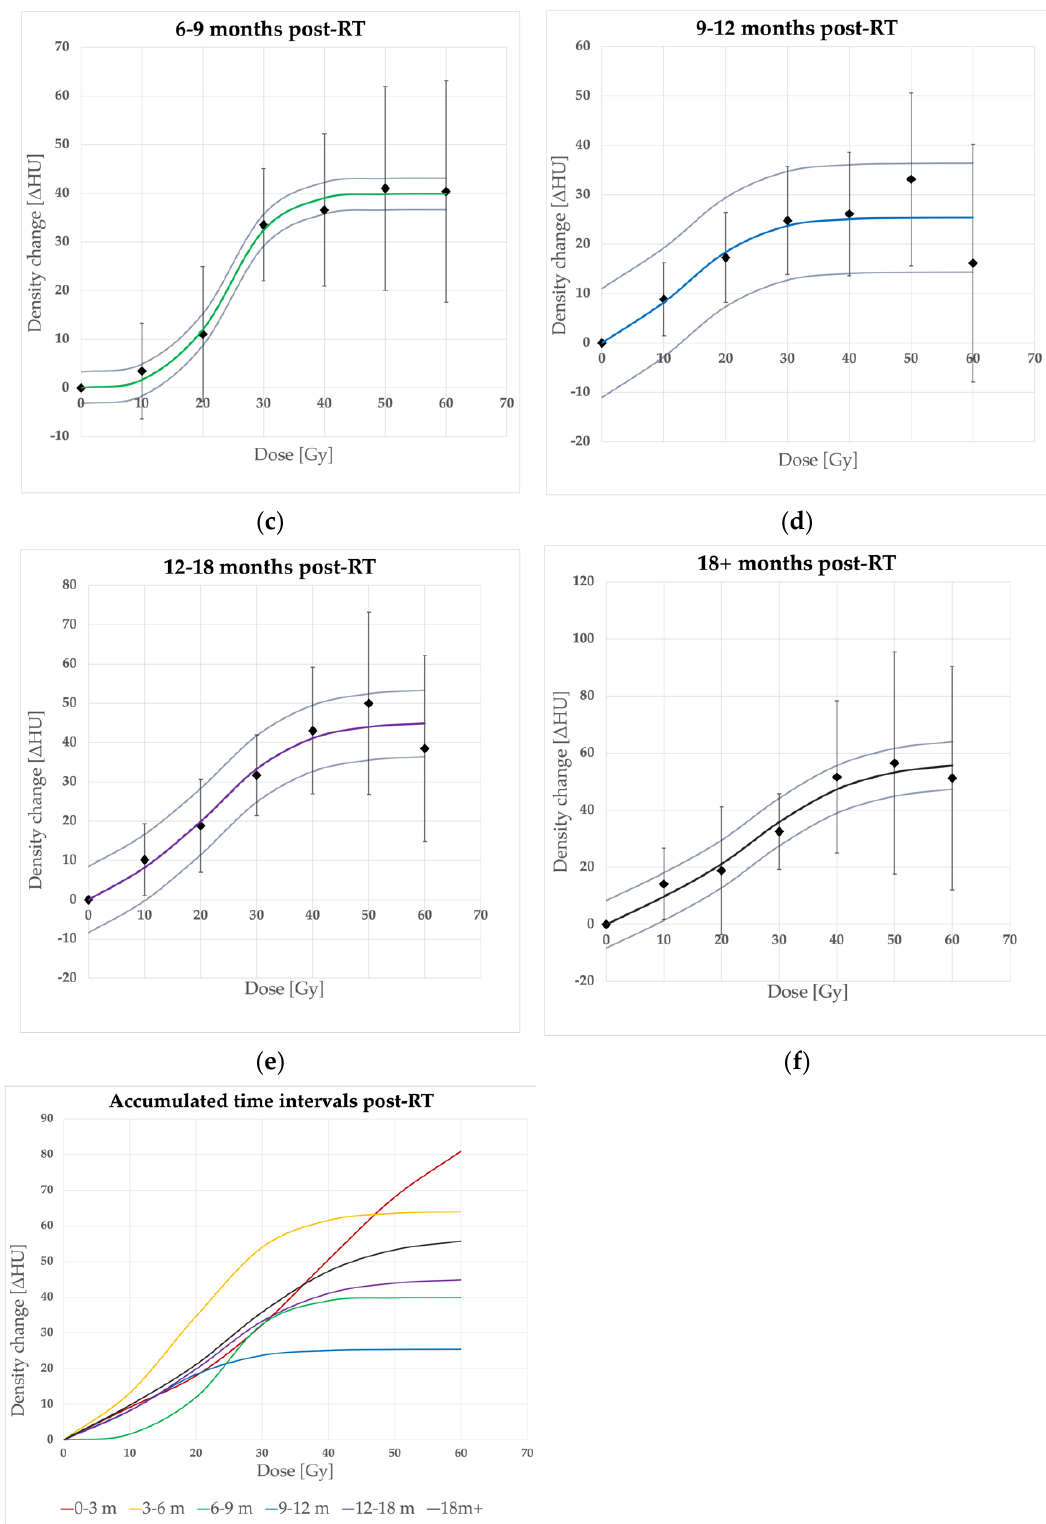
Figure 1. Dose-response sigmoidal model fit in consecutive time intervals. Density changes in time intervals after RT completion: ( a ) 0–3 months, ( b ) 3–6 months, ( c ) 6–9 months, ( d ) 9–12 months, ( e ) 12–18 months, ( f ) over 18 months, and ( g ) accumulated curves. 95% CI bars (for mean ∆ HU data points) and curves (for models) — omitted in ( g ) for clarity.